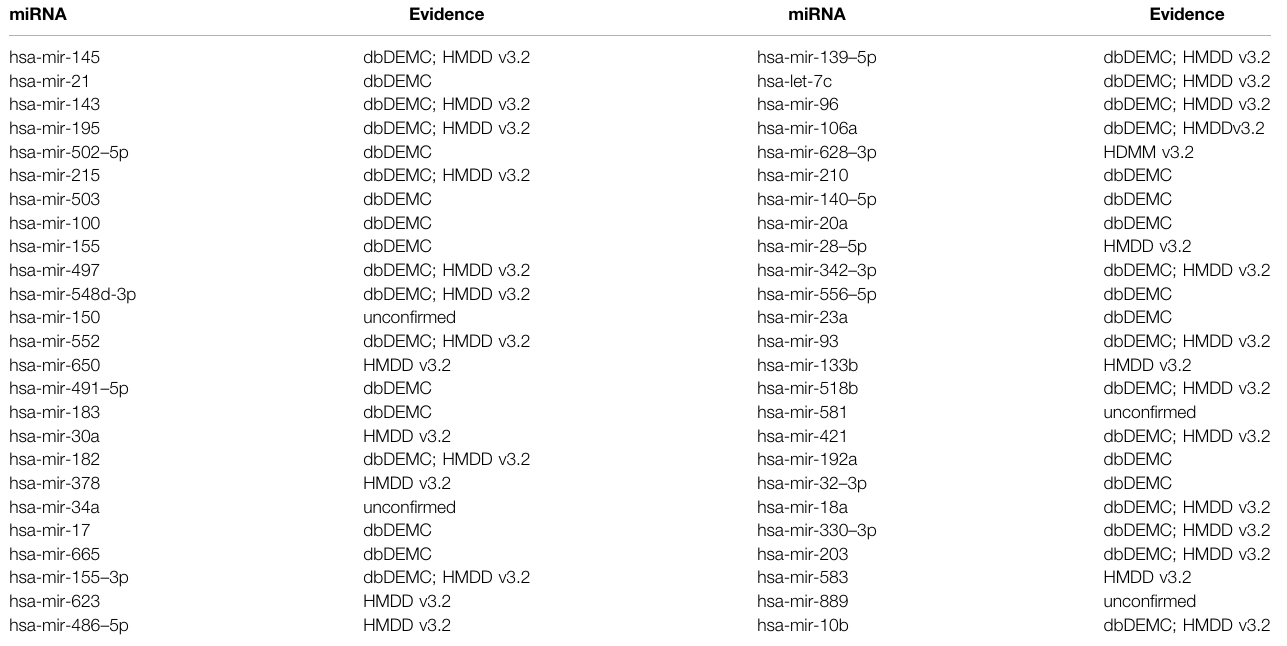
TABLE2| BasedontheknownassociationsprovidedbydbDEMCandHMDDv3.2,thetop50miRNAsrelatedtocolonneoplasmwerepredictedbyemployingBGANMDA model, and 46 predictions were con fi rmed based on dbDEMC and miR2Disease. The fi rst column records the top 1 – 25 predicted potentially related miRNAs and the third column records the 26 – 50 predicted potentially relevant